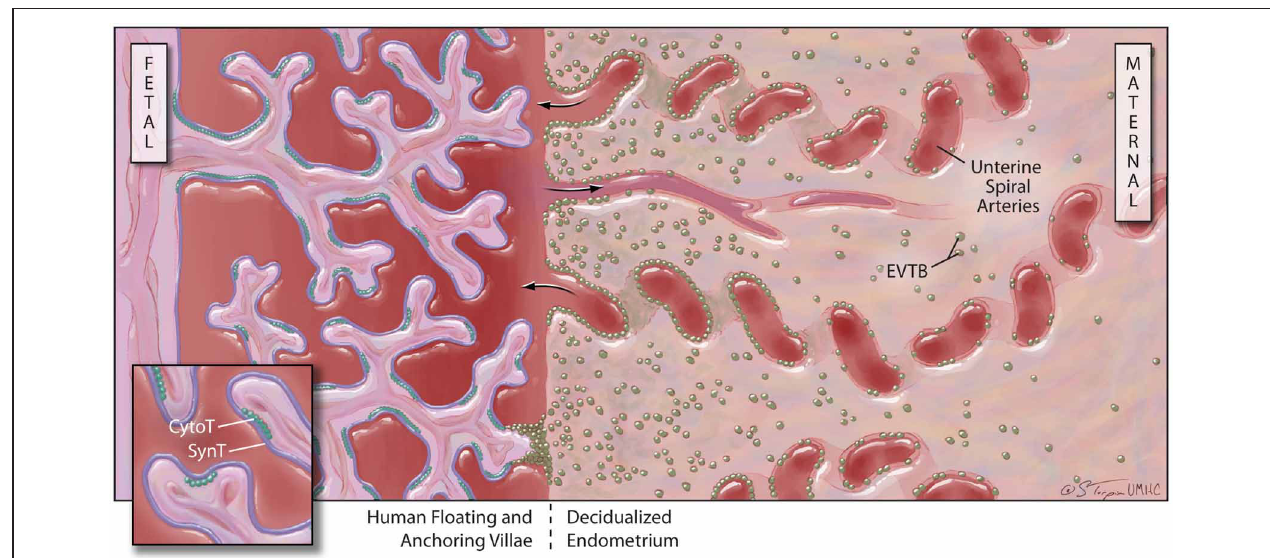
FIGURE 2 | Human placental structure (after 12 weeks of gestation): the human placenta has a fetal and a maternal side. The fetal side consists of a mass of tree-like villous structures that are bathed in maternal blood. Unlike floating villae, anchoring villae traverse the blood-filled intervillous space and attach to the maternal decidualized endometrium. The maternal decidua is populated by stromal and immune cells and is crossed by spiral arteries that